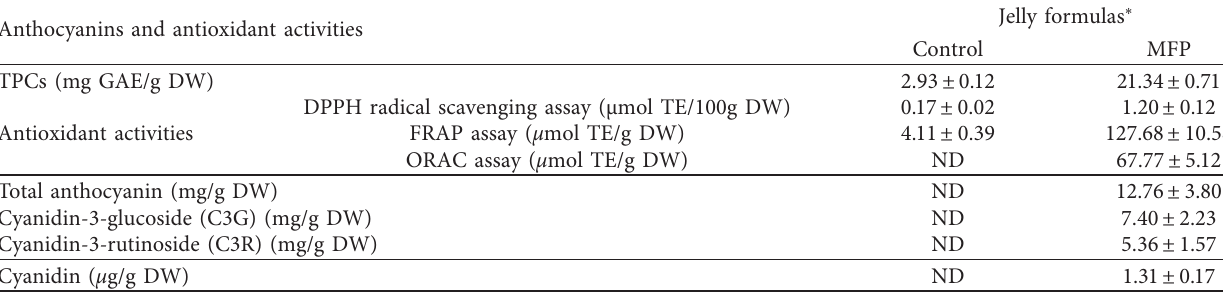
Table 4: Anthocyanins and antioxidant activities of MFP jelly 1 .